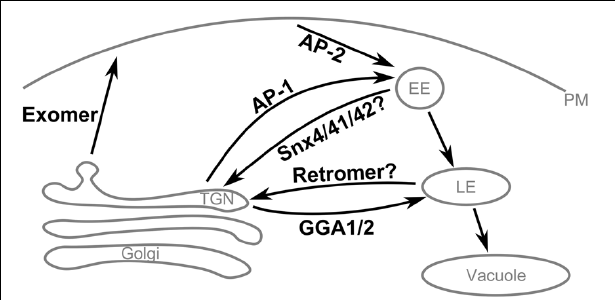
FIGURE 7 | Summary of Chs3 trafficking pathways. Chs3 is transported through several intracellular trafficking pathways throughout the cell cycle. As the yeast TGN is not a stable compartment, retention of cargo at the TGN appears to require traffic to endosomes by the AP-1 and Gga1/2 clathrin adaptors and subsequent retrieval back to the TGN, likely via the retromer and/or SNX4/41/42